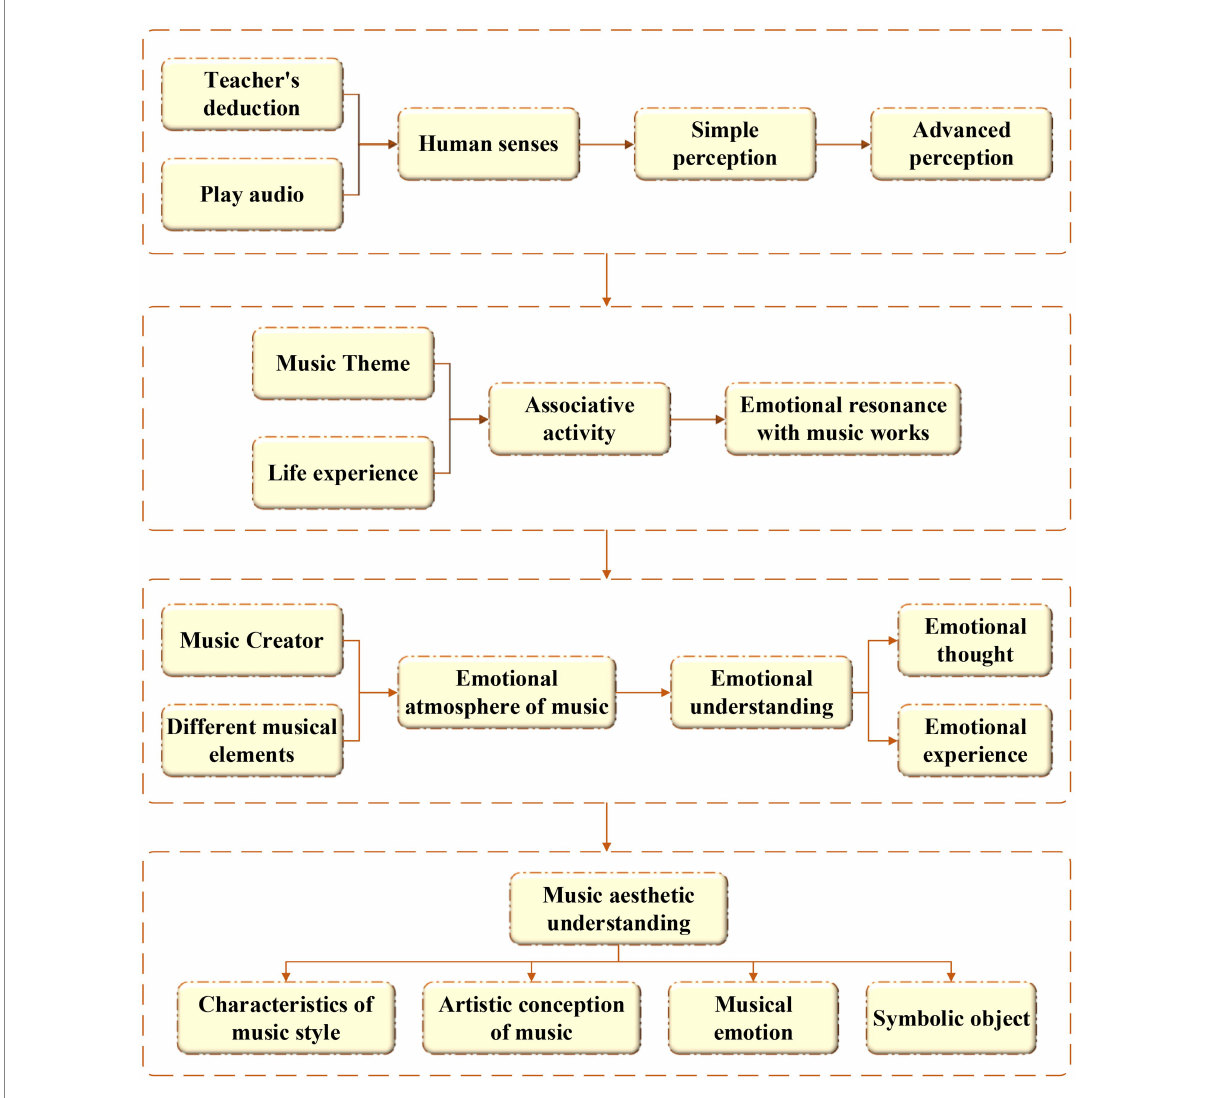
FIGURE 2 Relations of four psychological elements of aesthetic experience